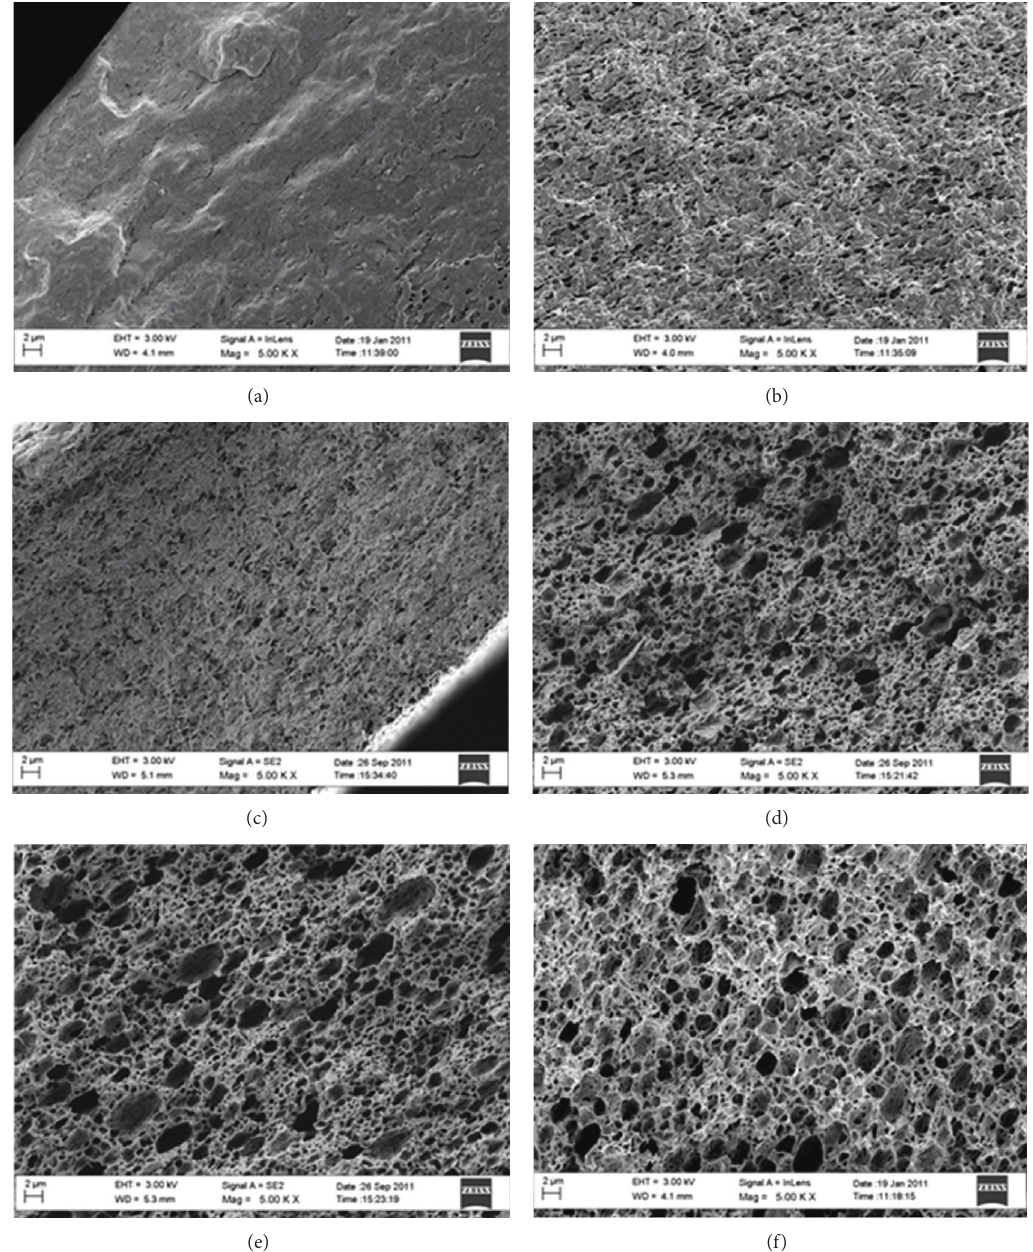
Figure 1: SEM images of PHB film cross sections made with (a) no emulsion template, (b) 3%, (c) 6%, (d) 8%, (e) 9%, and (f) 10% of water in the emulsion template. The lithium salt content of the water phase was 2.9% (w/v) for all template emulsions. The scale bar is 2 𝜇 m and the magnification is × 5 k. The picture was taken with horizontal detection